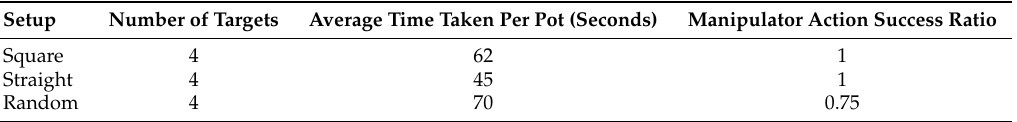
Table 1. Results of navigation and soil sensing